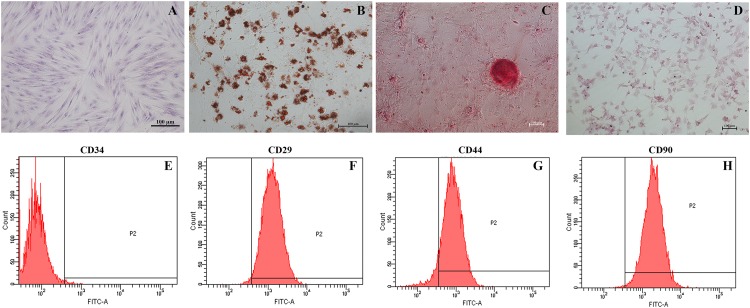
Identification of ADSCs. (A) Wright’s staining of passage three spindle-shaped ADSCs (magnification 200×). (B) Oil red O-stained lipid droplets in adipogenic cells (magnification 200×). (C) Alizarin Red-stained calcium crystals in osteogenic cells (magnification 100×). (D) PAS-stained glycogen masses in hepatic cells (magnification 100×). (E–H) Flow cytometry analysis of ADSCs indicating CD34– CD29+ CD44+ CD90+ immunophenotype.